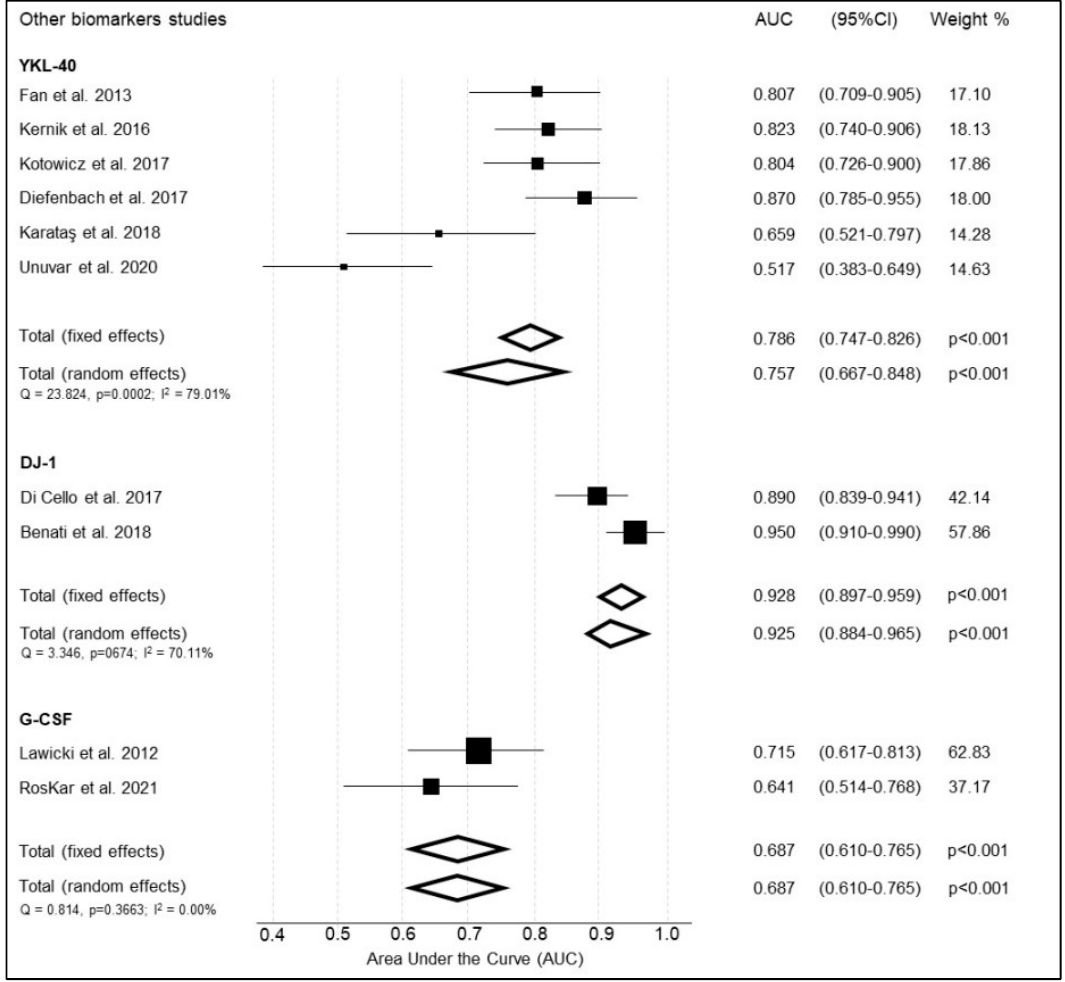
Figure 8. Summary of the diagnostic accuracy of other proteomic biomarkers included in the meta-analysis.